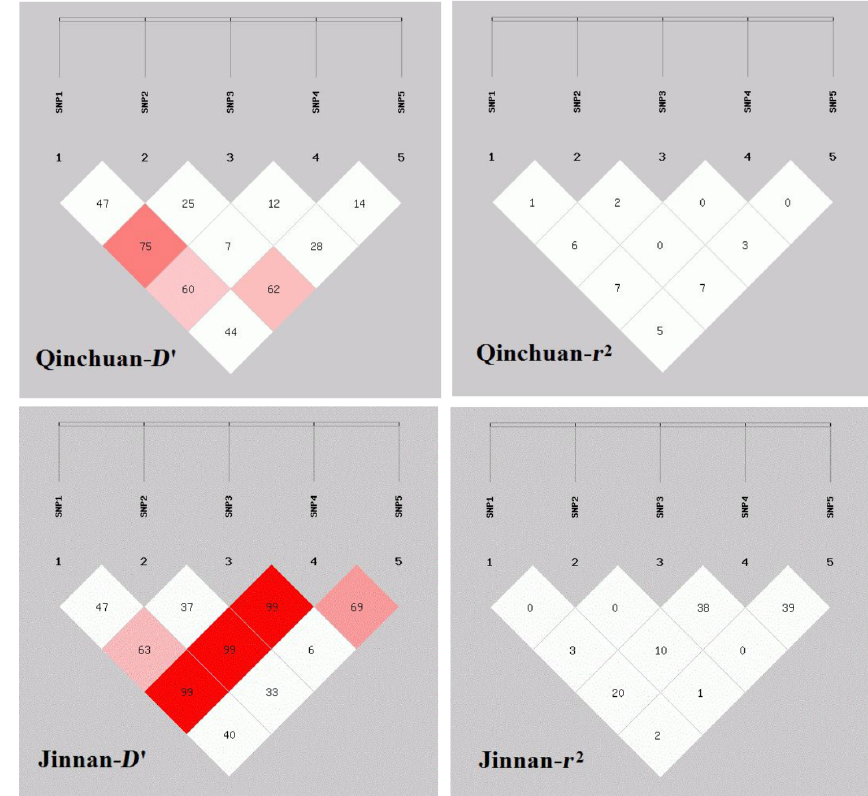
Figure 3. Linkage disequilibrium (LD) plot ( D (cid:48) and r 2 ) of five novel SNP loci within the ATBF1 gene in Qinchuan and Jinnan